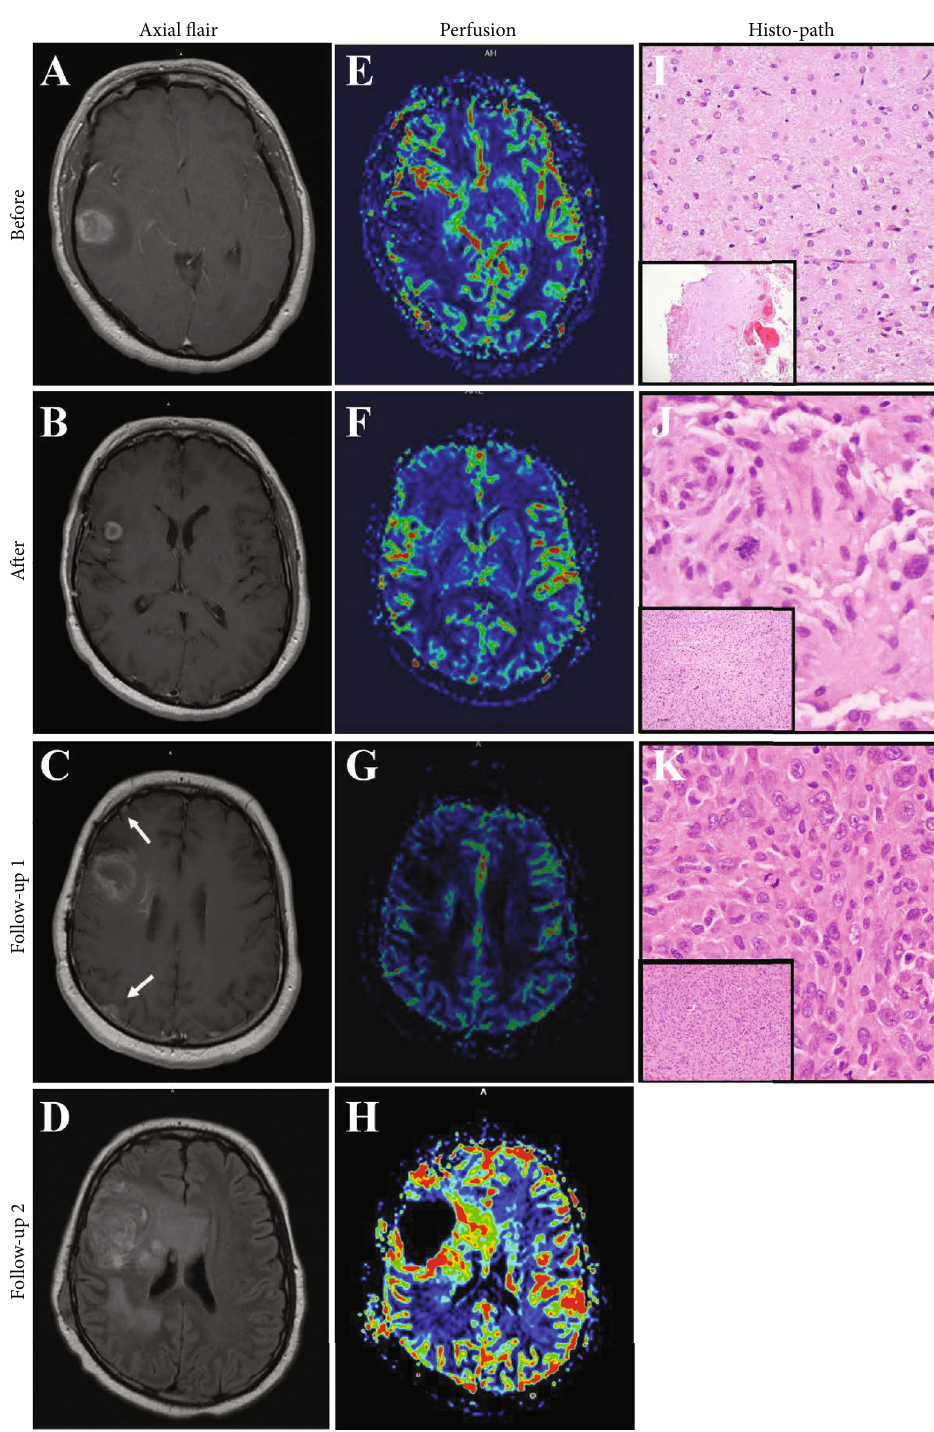
Figure 2: The progression of astrocytoma and development of dural-based nodules. (a – d) Images of axial MRI: a 2 : 4 × 2 : 5cm mass in the right lateral to midtemporal lobe and associated area of hemorrhage at initial presentation (a), a growing nodule of contrast enhancement in the right frontal lobe at 5 months after completion of RT (b), follow-up 1 after 6 cycles of bevacizumab (c), and an increase in dural- based nodules involving the entire right hemisphere and the left cerebellum as well as an increase in size of the centrally necrotic mass in the right frontal lobe at follow-up 2 of dural-based nodules (d). White arrows indicate new dural-based nodular areas of enhancement. (e – h) Images of MRI perfusion: at initial presentation (e), at 5 months after completion of RT (f), at follow-up 1 after 6 cycles of bevacizumab (g), and at follow-up 2 of dural-based nodules (h). (i – k) Representative images of H&E staining: an initial Grade II Astrocytoma at high and low (inset) power (i), dural nodule showing increased mitotic activity at high and low (inset) power (k), and Grade III Astrocytoma at high and low (inset) power after second tumor resection